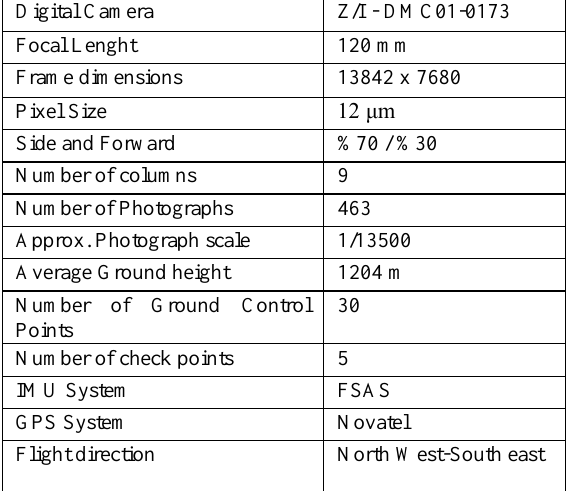
Table 1: Flight Parameters